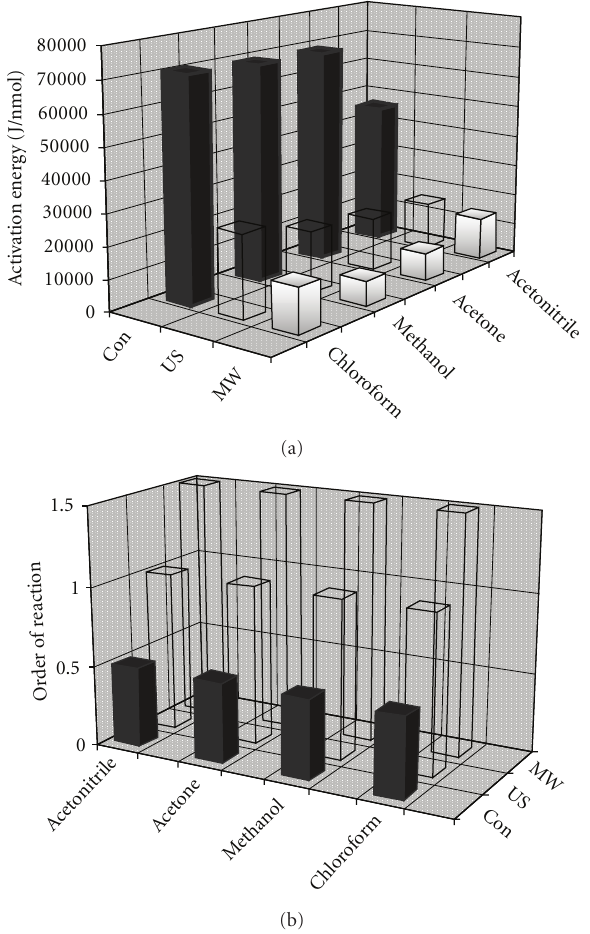
Figure 6: Values of Ea (a) and n (b) for the allicin transformation by conventional method (Con), under the influence of ultrasound (US) and microwaves (MW).